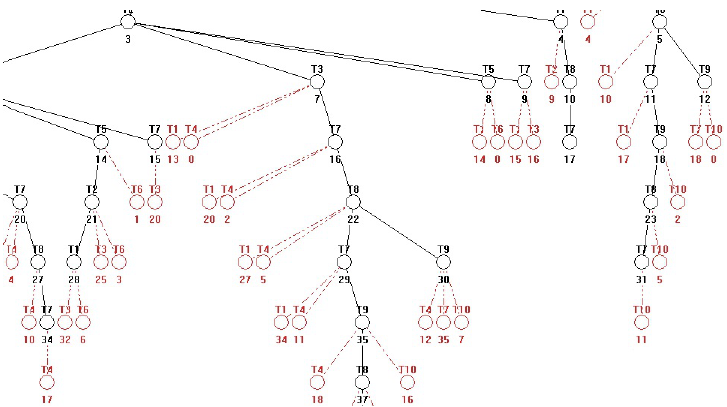
Figure 12. The segment of the PN model RT containing the deadlock and access paths to